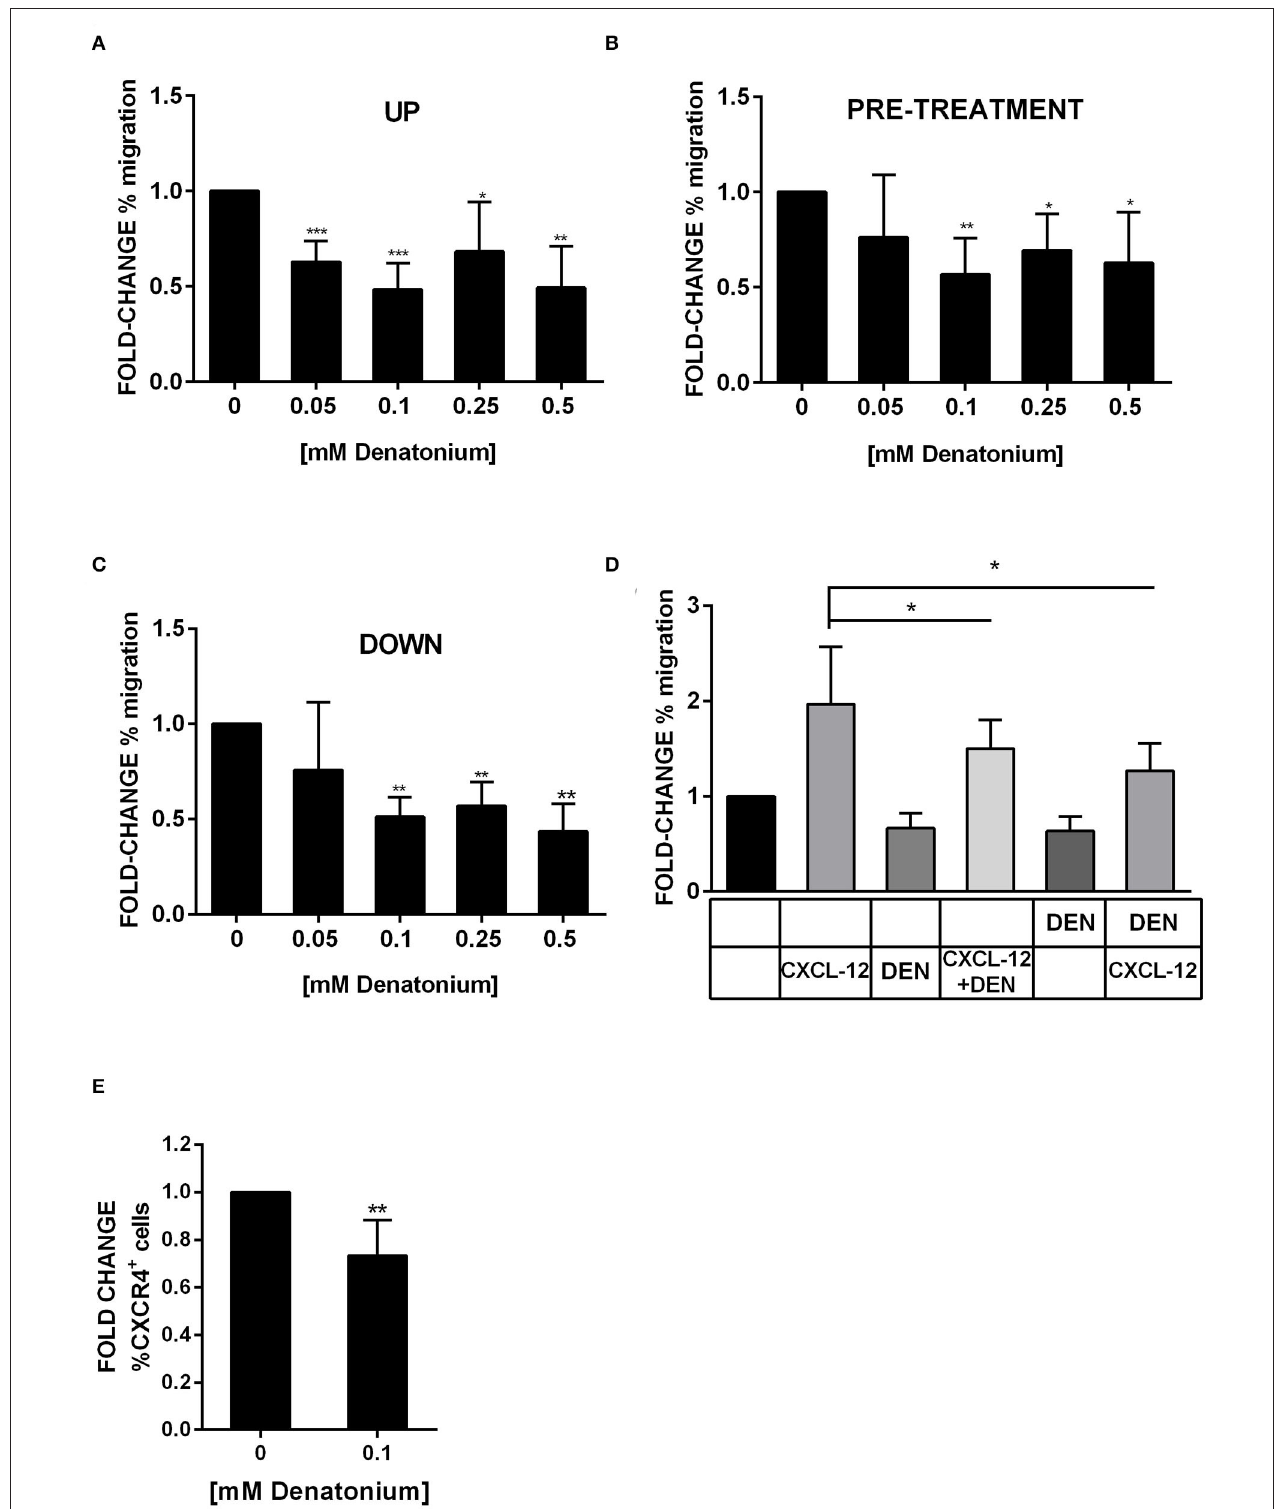
FIGURE 8 | DEN stimulation inhibits AML cell migration. Results of AML cell migration in transwell assays were shown as fold-change of the percentage of migration in comparison with the untreated condition set as 1. (A) Spontaneous migration of AML cells in presence of increasing doses of DEN in the upper chamber of